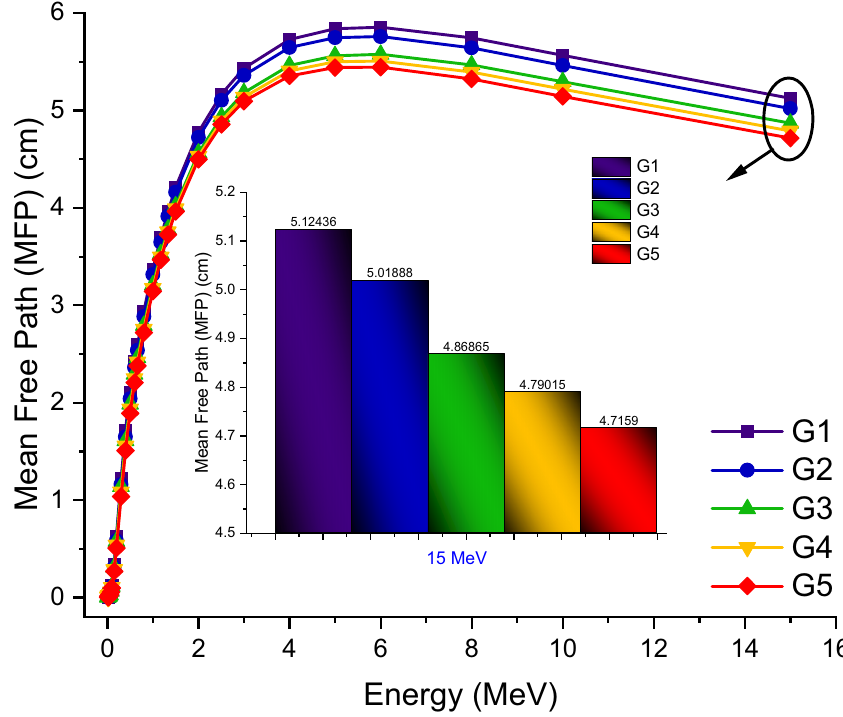
Figure 6: Variation of mean free path ( cm ) with photon energy ( MeV ) for all G1 – G5 glasses.